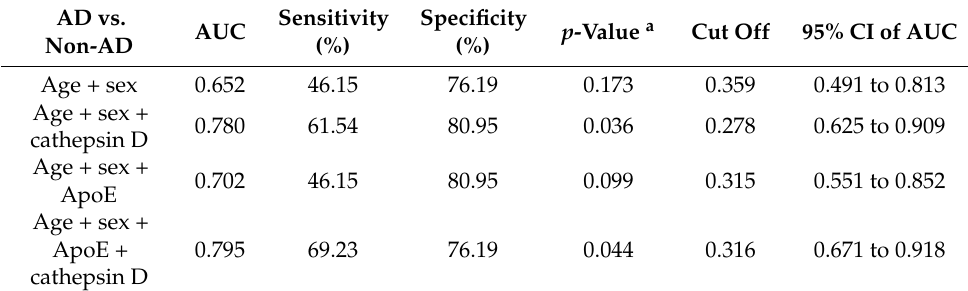
Table 2. Detailed information on receiver operating characteristic (ROC) curve analysis.